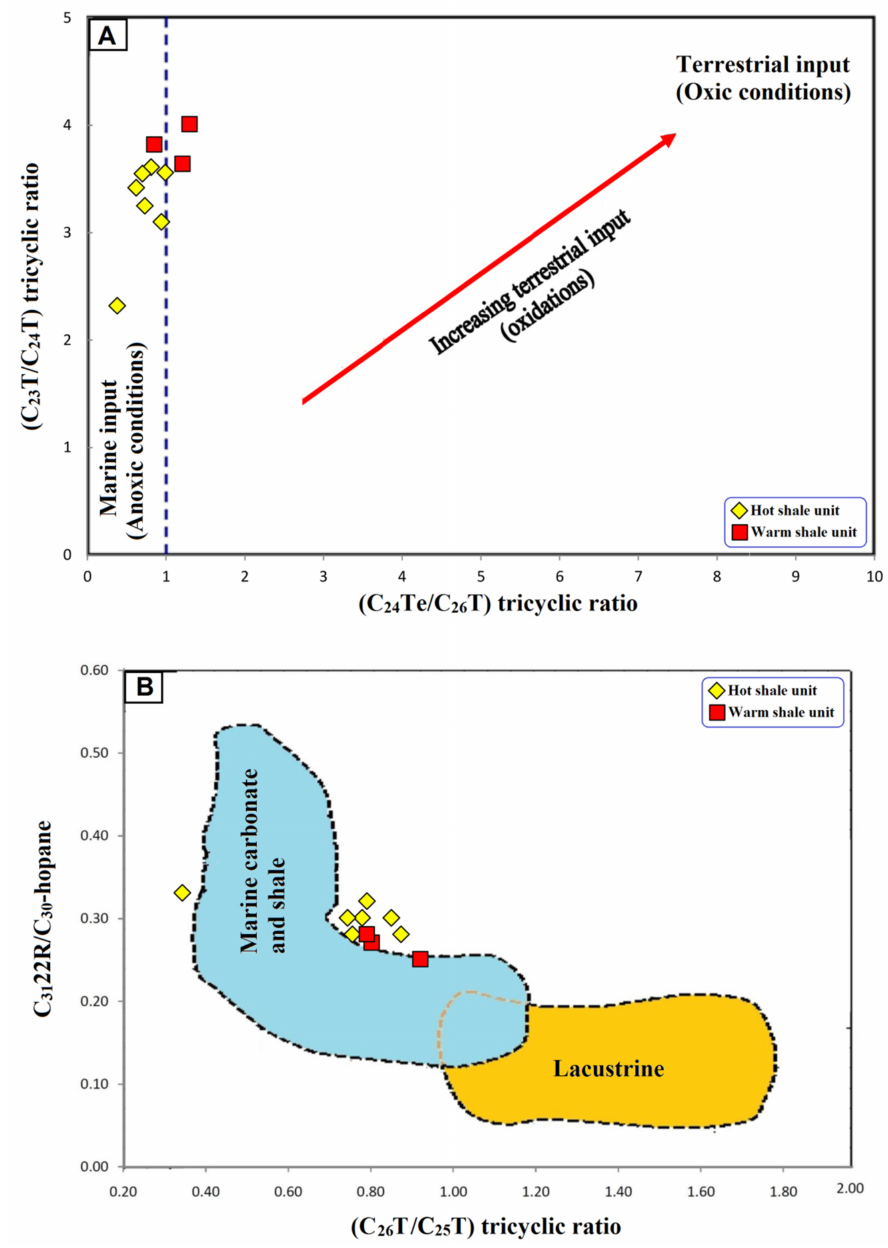
Figure 11. Geochemical biomarker results of the analyzed shales of the Qusaiba units show- ing ( A ) C23 tricyclic/C24 tricyclic (C23T/24T) versus C24 tetracyclic/C26 tricyclic (C24Te/C26Ti) and ( B ) C26 tricyclic/C25 tricyclic (C26T/C25T) versus C31 regular homohopane/C30hopane (HCR31/HC30), further indicating that these sediments contain mainly marine organic matter and were deposited under suboxic to anoxic environmental